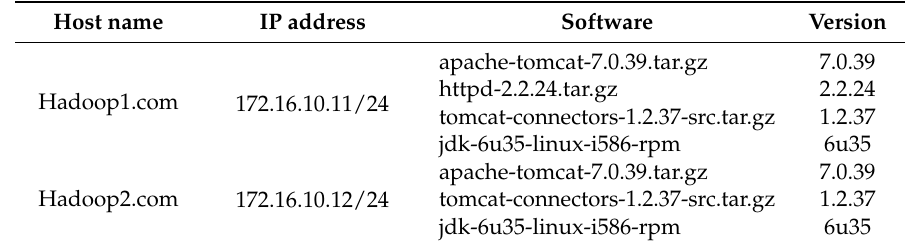
Table 3. Software installed on